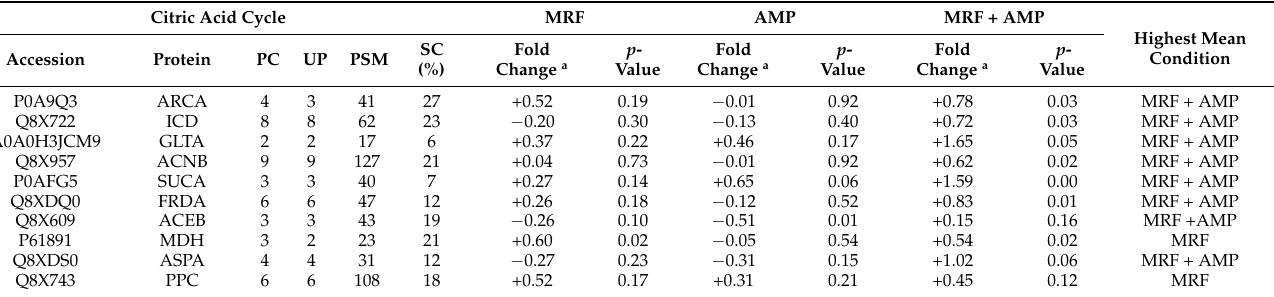
Table 1. The influence of MRF (1 mgmL − 1 ) and antibiotic treatment AMP (0.1 mgmL − 1 AMP) on fold-change expression (normalized peptide abundance) of intermediates of the citric acid cycle of antibiotic-resistant E. coli relative to the control.